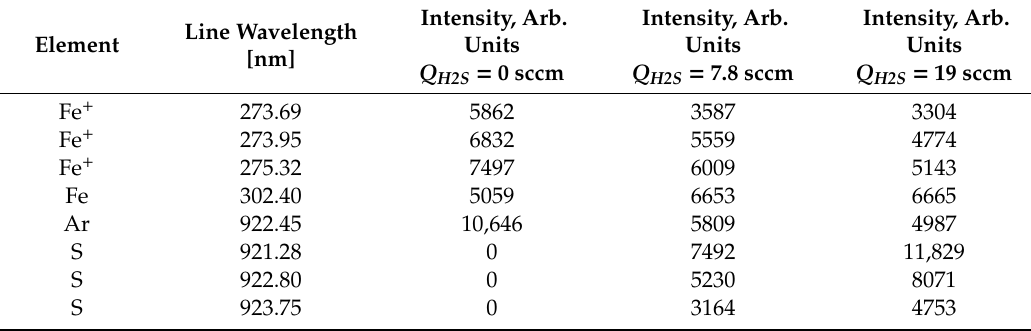
Figure 6. Emission spectra with S and Ar spectral lines of HiPIMS plasma for different mass flow rates of H 2 S gas Q H2S ( a ) for H 2 S gas flow Q H2S = 0 sccm, ( b ) for H 2 S gas flow Q H2S = 7.8 sccm, ( c ) for H 2 S gas flow Q H2S = 19 sccm. Table 3. Emission spectra of observed elements Fe, Fe+, S, and Ar.